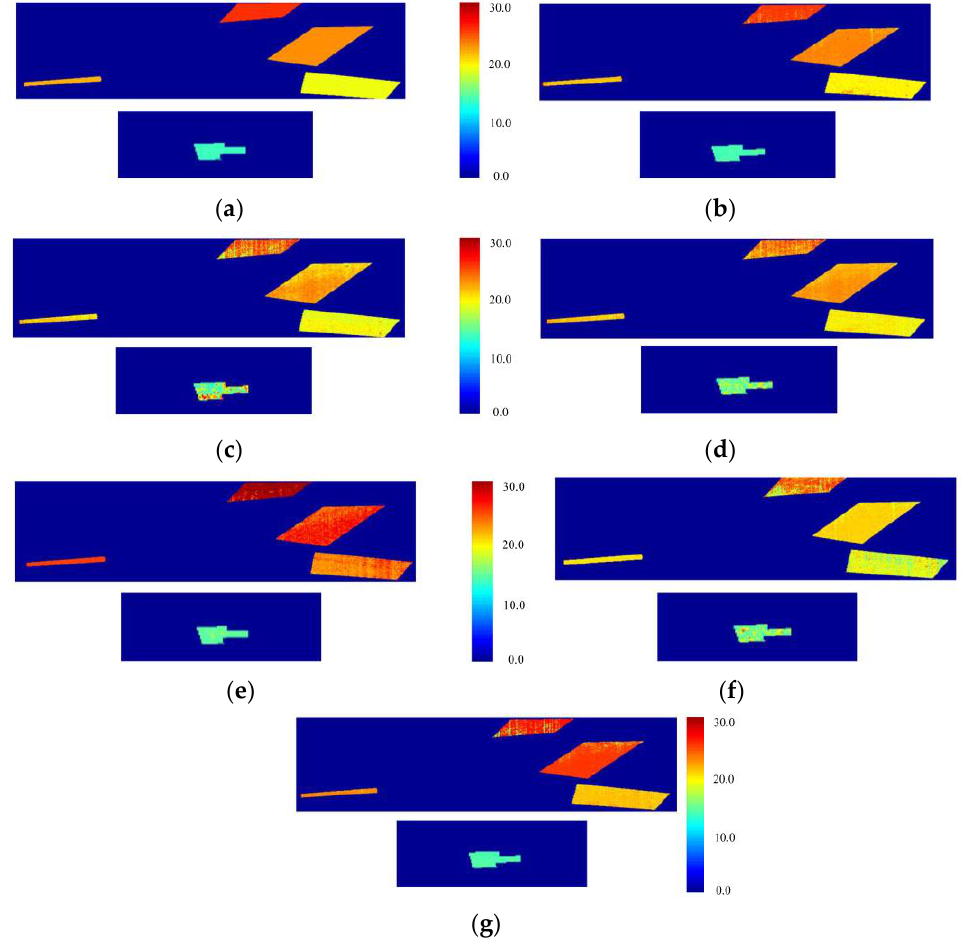
Figure 9. Regression results on the field dataset. ( a ) Ground truth map of field data. Regression results of the ( b ) dual-channel CNN, ( c ) MLP, ( d ) SVM, ( e ) X-Bragg-CNN, ( f ) IEM-CNN, and ( g ) 6CH-CNN. Table 11. Field data RMSE and r 2 of the dual-channel CNN, MLP, SVM, X-Bragg-CNN, IEM-CNN, and 6CH-CNN. Net RMSE (%) r 2 Dual-channel CNN